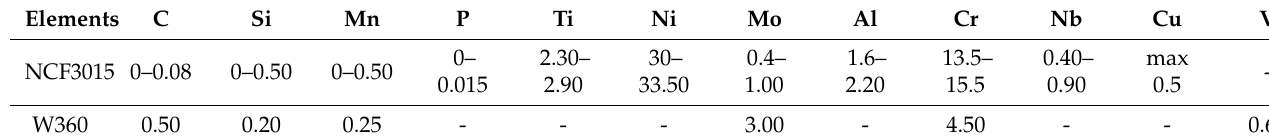
Table 1. The chemical composition of the input material (NCF3015) and tools (W360) [%].